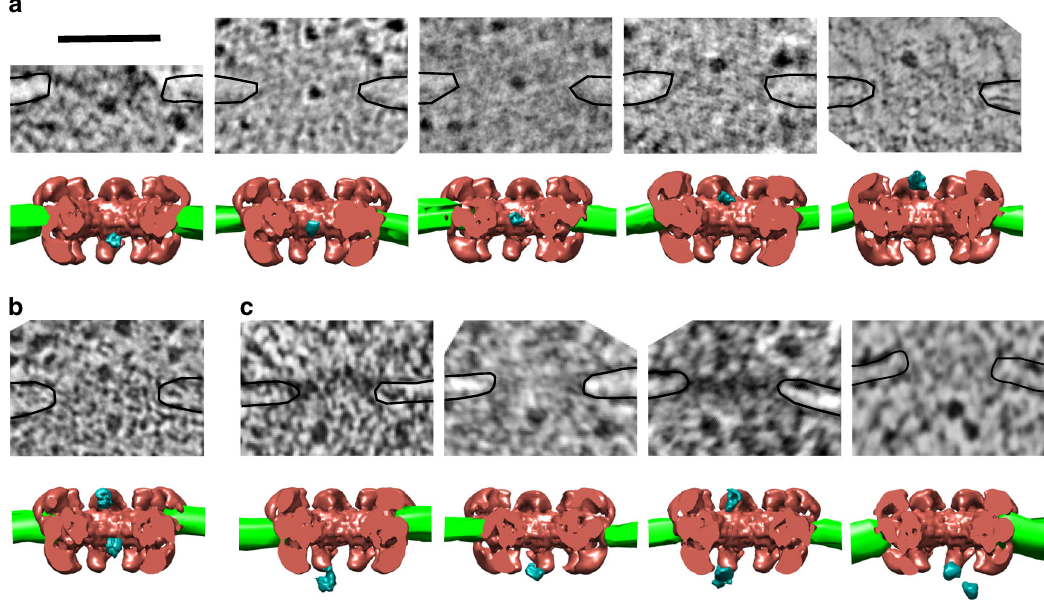
Fig. 3 3D-rendering of pre-ribosomal particles within the NPC. a The yeast NPC model was docked into subtomograms showing pre-ribosomal particles in various regions of the NPC in NOY505 or OGP103 cells. The gallery displays tomographic sections and the corresponding 3D models. Pre-ribosomal particles are segmented in blue, the nuclear envelope in green and the docked NPC model is shown in red. b An example of NPC containing two pre- ribosomal particles. c In nmd3-2 ts cells at 37 °C, most pre-ribosomal particles were found at the nuclear ring or below. Black lines indicate the nuclear envelope. Scale bar: 100